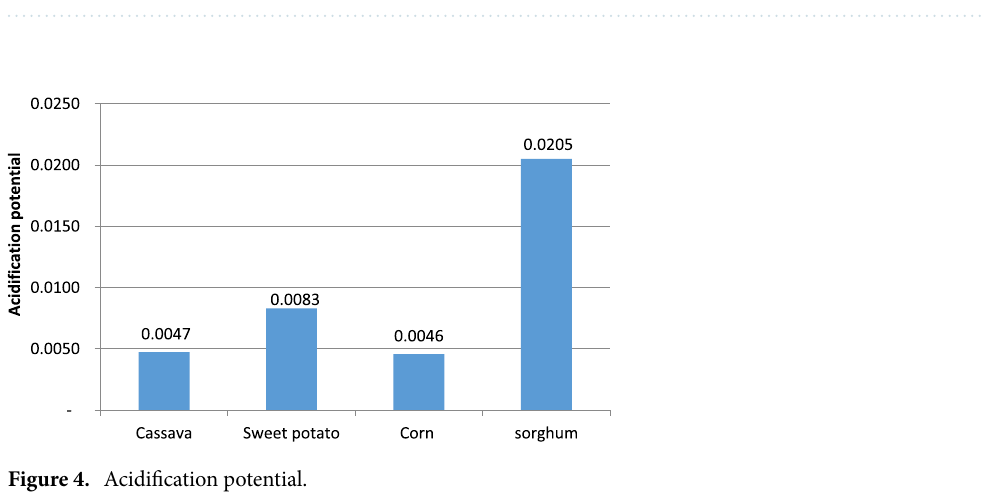
Table 6. Percentage contribution of pollutants to environmental impact.